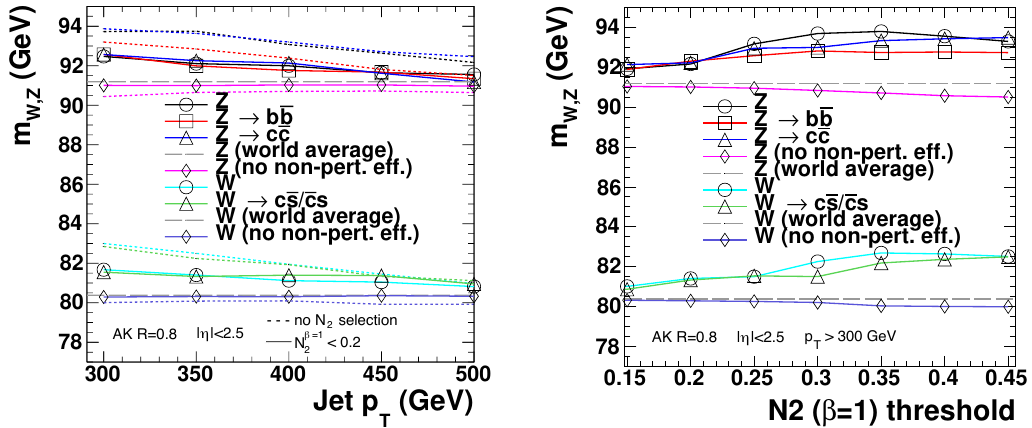
Figure 8 . Dependence of the W and Z jet mass on the jet p T and N (cid:12) =1 simulation. In the left plot solid lines correspond to a selection of N (cid:12) =1 no N (cid:12) =1 selection. Curves labeled \no non-pert. e(cid:11)." correspond to predictions without simulation 2 of hadronization and underlying event e(cid:11)ects. The measured world average values of the W and Z mass taken from ref. [13] are shown for